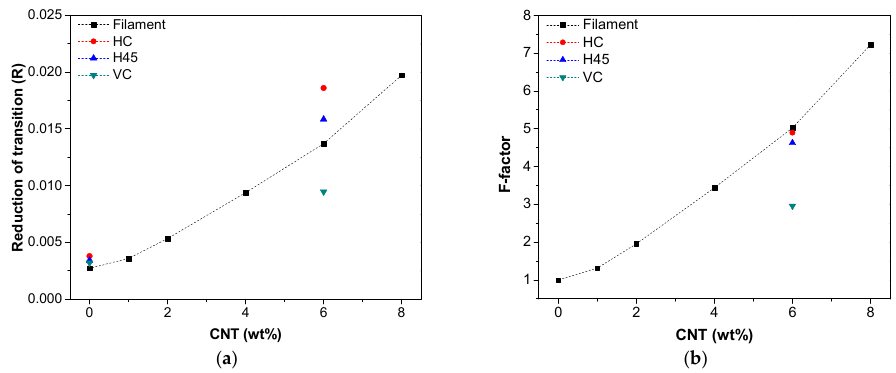
Figure 11. Reduction of main transition of storage modulus- R ( a ) and F -factor ( b ) as function of CNT nanofiller loading measured on filaments and 3D-printed samples (HC, H45 and VC).